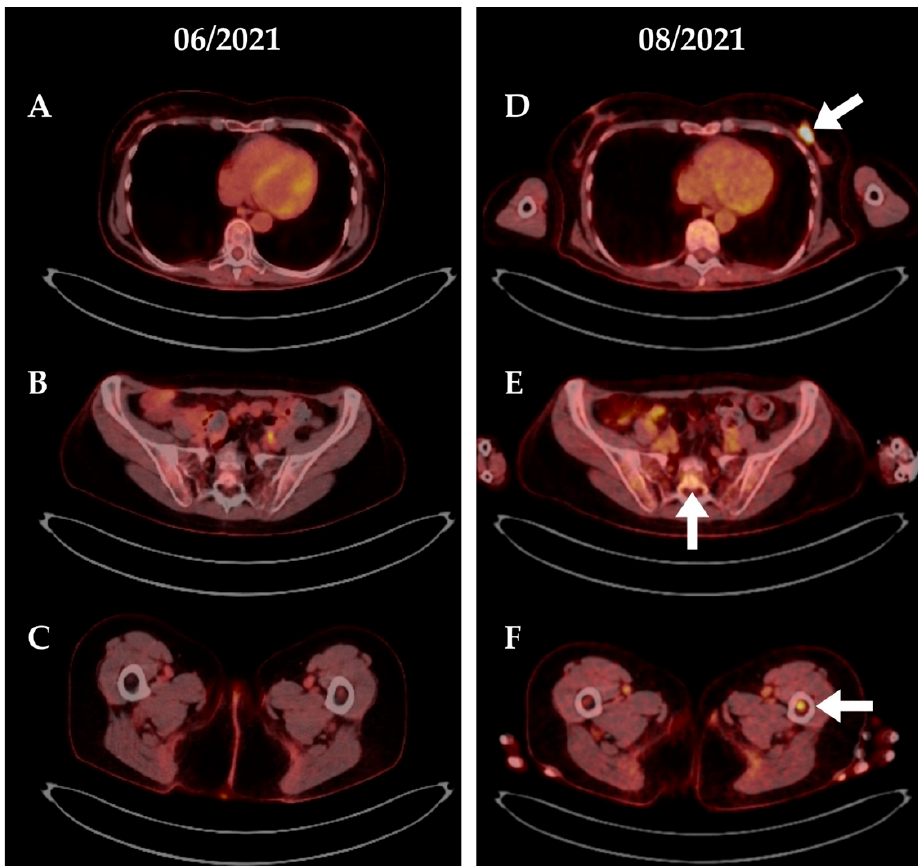
Figure 2. PET/CT scans of patient #1. Relapse after CAR T therapy. Three months after CAR T reinfusion, the patient had a complete remission without evidence of pathologic metabolic activity (panels A – C ). Five months after CAR T therapy, the patient relapsed with new lymphoma manifestations (white arrows) in the left breast (panel D ), the sacral canal (panel E ) and the left femur (panel F ). Biopsy of the left breast showed extensive infiltration of CD3+ T lymphocytes but no conclusive evidence of mantle cell lymphoma. Flow cytometric analysis of cerebrospinal fluid revealed evidence of CD19+, CD20+, CD5- clonal B cells confirming CNS relapse of mantle cell lymphoma. A prompt treatment with the bispecific CD20/CD3 antibody glofitamab was initiated together with a single dose of preceding obinutuzumab to mitigate the risk of tumor lysis and CRS and ICANS, as prescribed by the manufacturer. Despite a marked increase